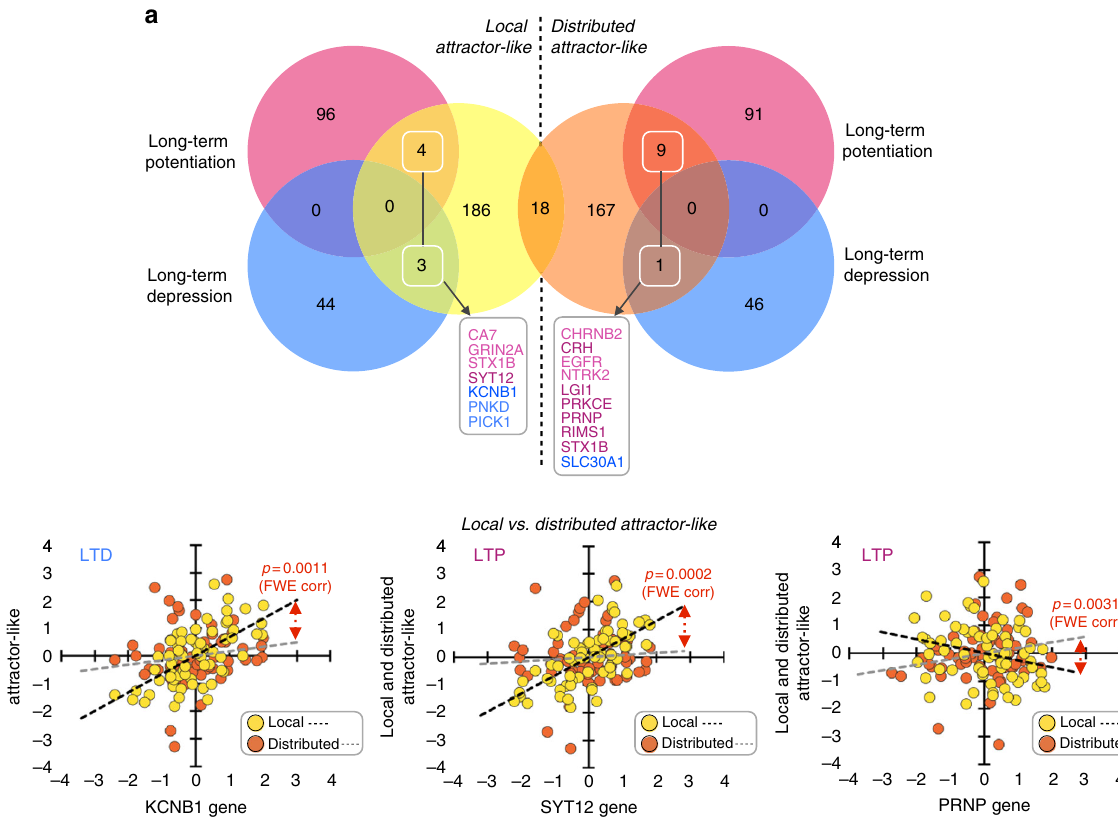
Fig. 6 Venn diagram showing genes involved in LTP and LTD processing within the genetic background found to be associated with dynamic connectivity maps (boxes in diagram; left shows local, right shows distributed). Scatterplots show the signi fi cant differences between the local connectivity – genetic and global connectivity – genetic associations in KCNB1 (LTP), SYT12 (LTD) and PRNP (LTP) genes (FWE correction